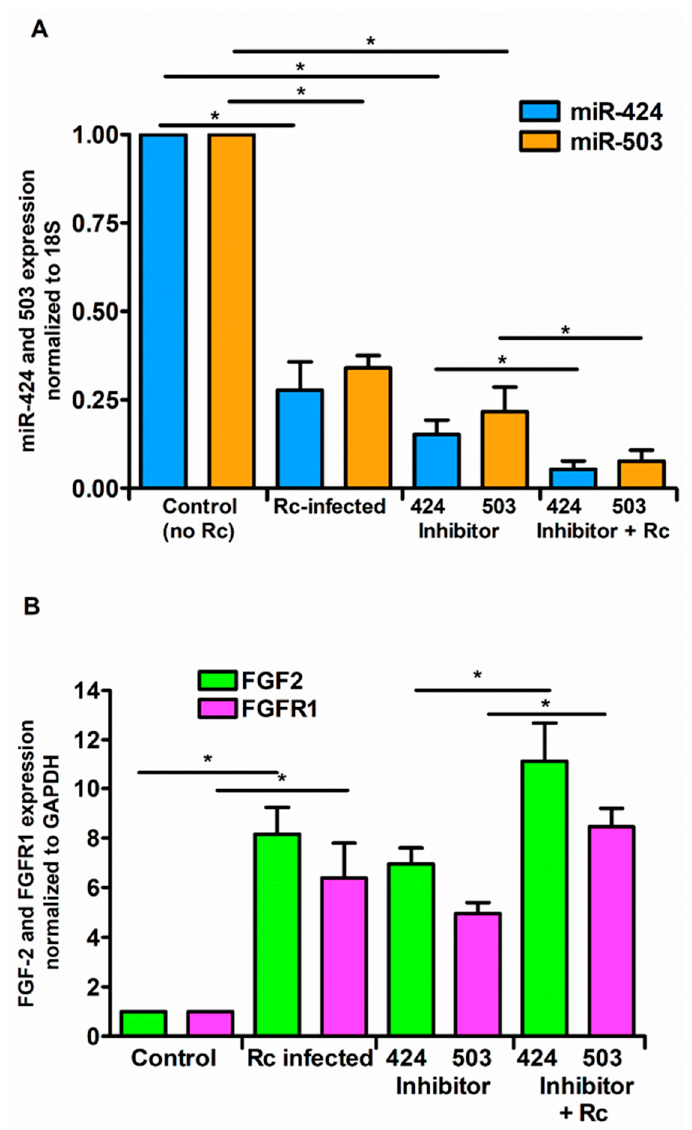
Figure 5. Effect of miRNA inhibitors on expression levels of FGF2/FGFR1. ECs were transfected with miR-424 or miR-503 inhibitor (200 nM) for 72 h using Lipofectamine RNAiMAX according to the manufacturer’s instructions and then infected with R. conorii for 6 h. Cells were lysed in Tri Reagent and total RNA was isolated for measuring the expression of miR-424 and miR-503 ( A ) and FGF2/FGFR1 ( B) by qRT-PCR. The data are presented as the mean ± SE of three separate experiments. The asterisk (* p ≤ 0.01) indicates statistically significant change.